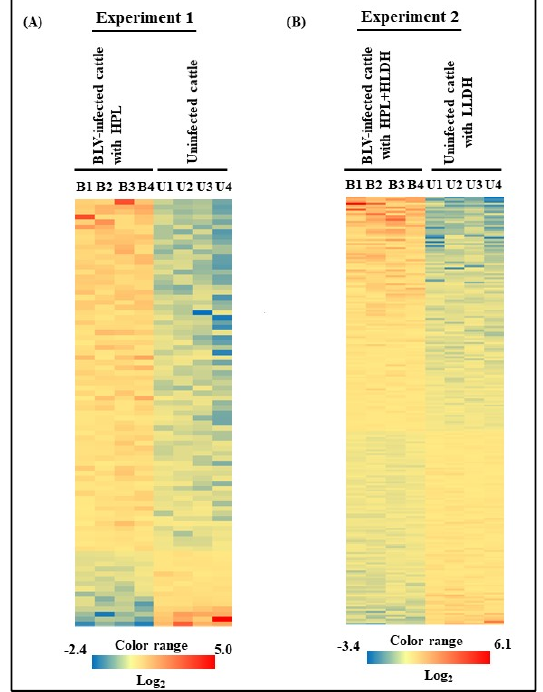
Figure 2. Heat map of DEGs in milk EVs from BLV-infected cattle with HPL and uninfected cattle in Experiment 1 ( A ) and BLV-infected cattle with HPL + HLDH and uninfected cattle with LLDH in Experiment 2 ( B ) were shown. Color-coded scale bar represents the relative content of genes. High level of expression was shown in red and low level was shown in blue.